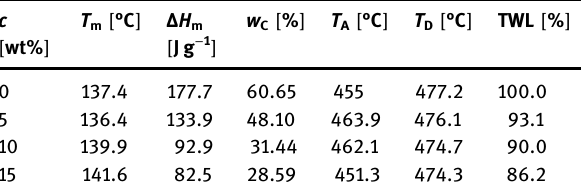
Table 2: Results of the thermal analysis of the virgin HDPE and perlite/HDPE